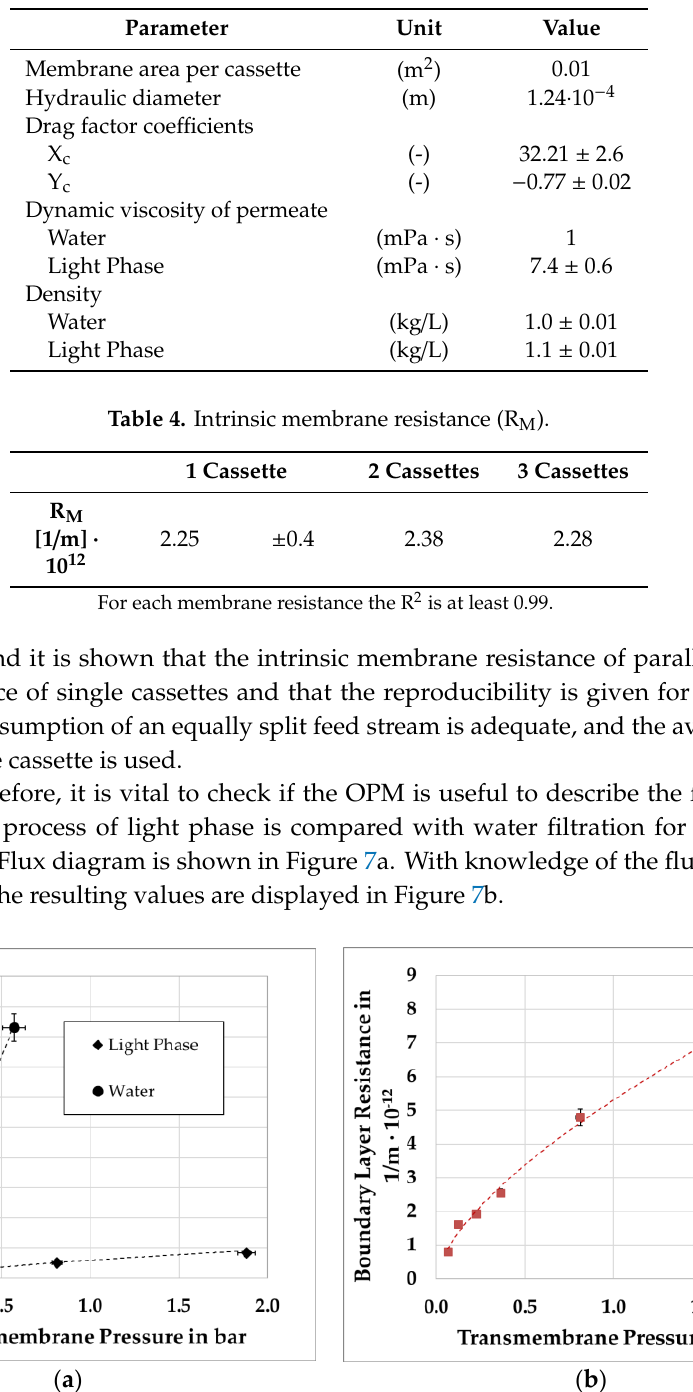
Table 3. Module and Solution parameter.